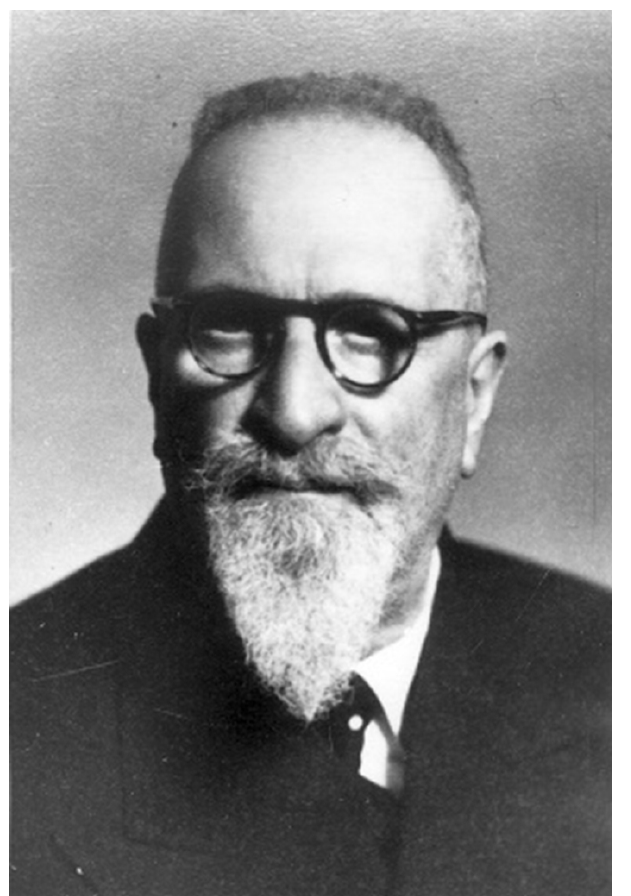
Figure 4. Victor Conrad (1876–1962) (ZAMG